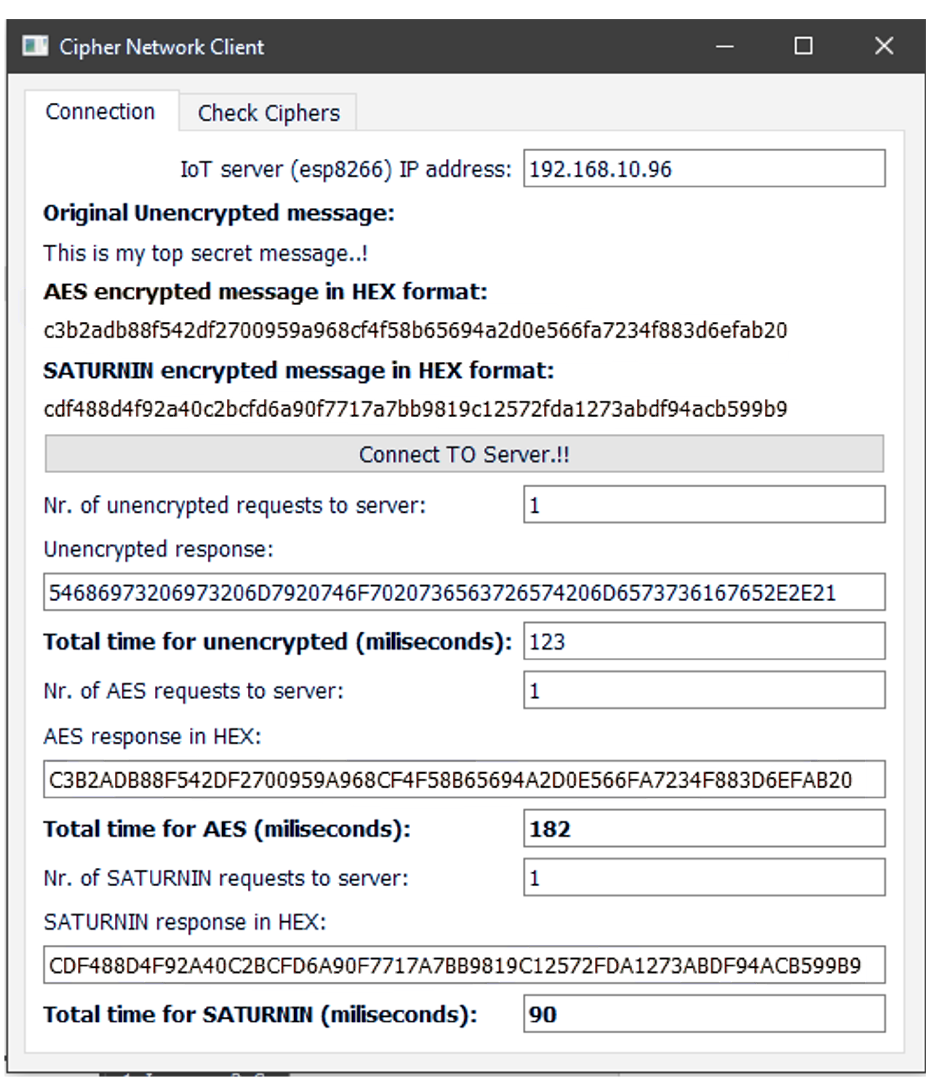
Figure 1. A screenshot from the client application, illustrating the responses that the client receives and the messages that it prints regarding the time